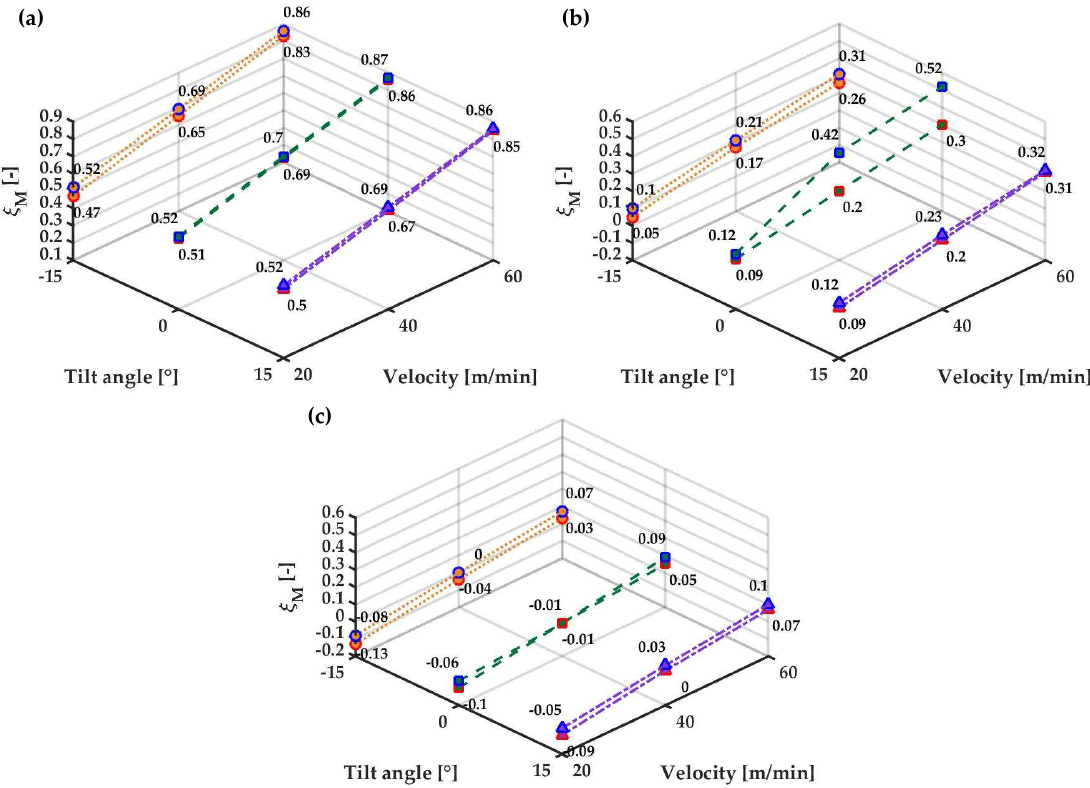
Figure 8. Mass sealing effectiveness coefficient at section α for AC mass flow ( a ) 3%; ( b ) 5%; ( c ) 7%.